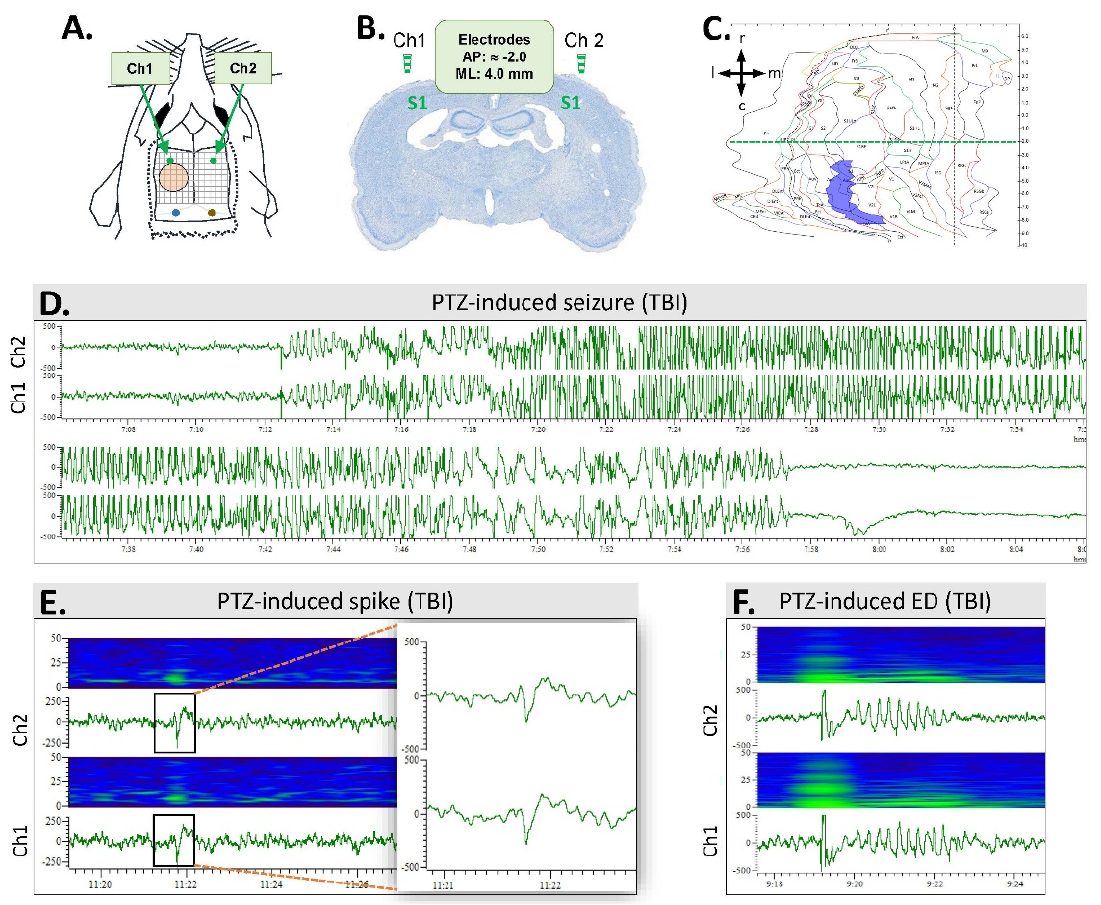
Figure 3. Electrode montage and pentylenetetrazol (PTZ)-induced epileptiform activities: ( A ) Elec- troencephalogram (EEG) was monitored using 2 epidural screw electrodes (Ch1 and Ch2) implanted bilaterally, rostral to the level of the anterior edge of the craniotomy (orange circle). Reference (blue) and ground (brown) electrodes were placed above the cerebellum. Grid 1 mm × 1 mm. ( B ) A coronal thionin-stained section from the level of epidural electrodes above the S1 cortex of a rat with TBI (case #11). The level is slightly rostral to the beginning of the lateral-fluid-percussion-induced cortical lesion. Note the enlarged lateral ventricles. ( C ) A computer-generated unfolded cortical map of case #11, demonstrating the location and area (7.72 mm 2 ) of the cortical lesion (violet). The horizontal dashed green line indicates a bregma level of − 2.0 (corresponding to panel B, taken approximately 1 mm rostral to the beginning of the cortical lesion). Arrows indicate the orientation of the cortical unfolding (r, rostral; c, caudal; m, medial; l, lateral). ( D ) A PTZ-induced seizure in a TBI rat (case #9). ( E ) A heatmap and an EEG trace showing a PTZ-induced spike in a TBI rat (case #9). The insert on the right shows the spike enlarged. Time scale is on the x -axis and voltage (300 µ V) on the y -axis. ( F ) A heatmap and an EEG trace showing a PTZ-induced epileptiform discharge (ED; case #45).